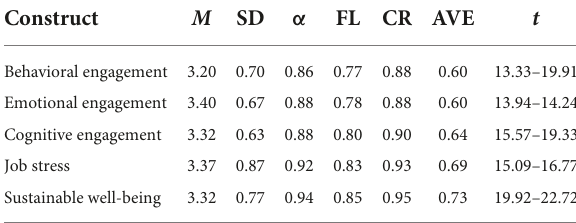
TABLE 3 Reliability and validity analysis.